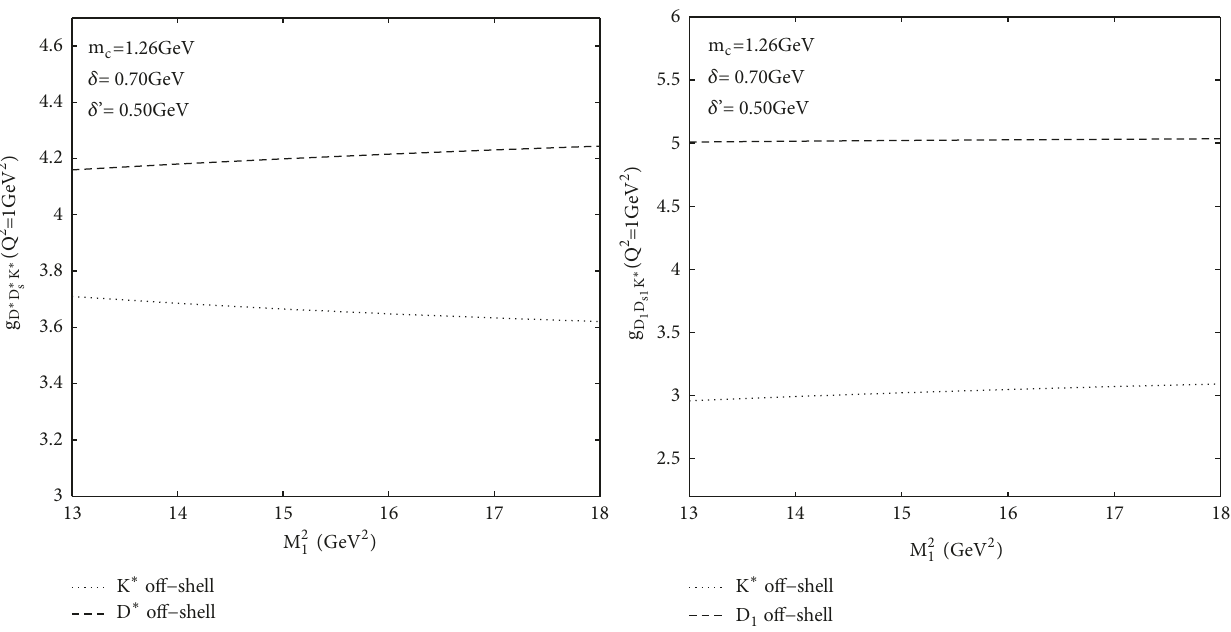
(left) and 𝑔 퐷 (right) as functions of the Borel mass parameter 𝑀 2 1 for off-shell charm and 𝑠1 퐷 1 퐾 ∗ 𝑠 퐷 ∗ 퐾 ∗